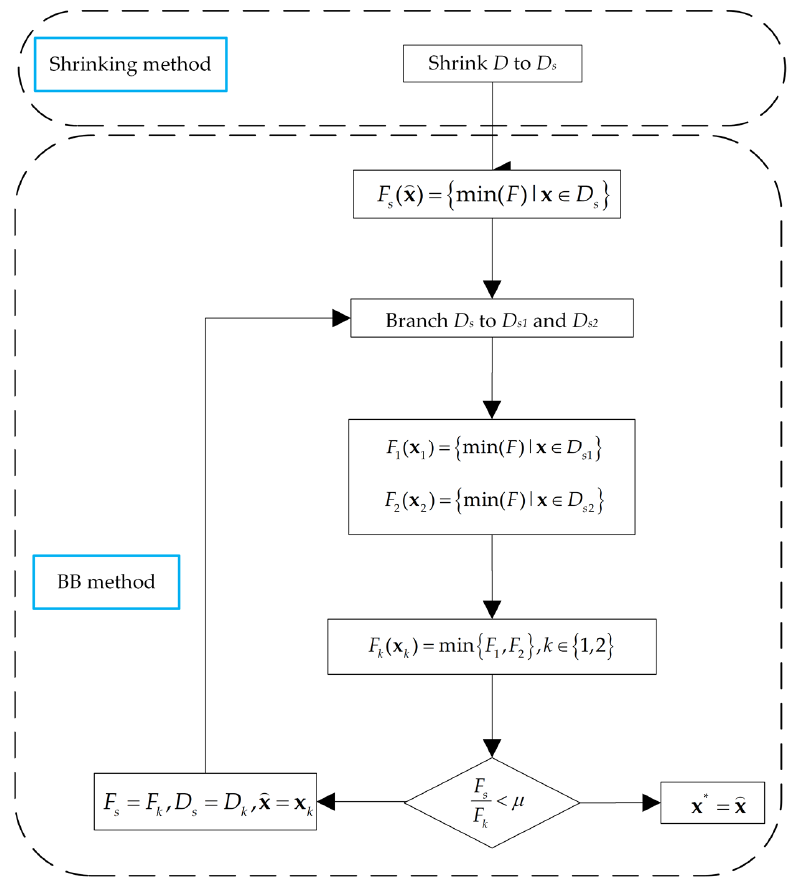
Figure 5. A diagram of the shrink ‐ branch ‐ bound algorithm.